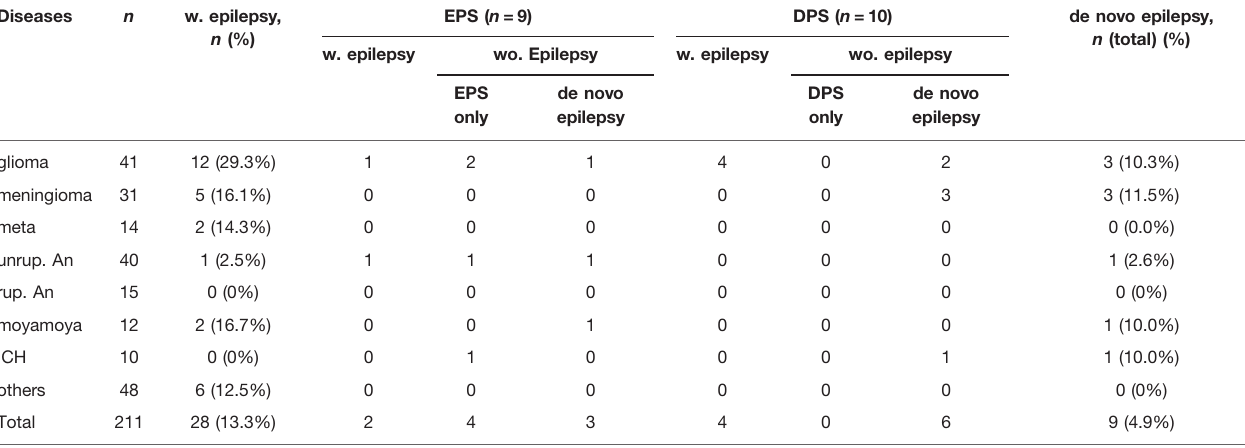
TABLE 2 | Clinical characteristics of epilepsy, EPS, DPS and de novo epilepsy. Diseases